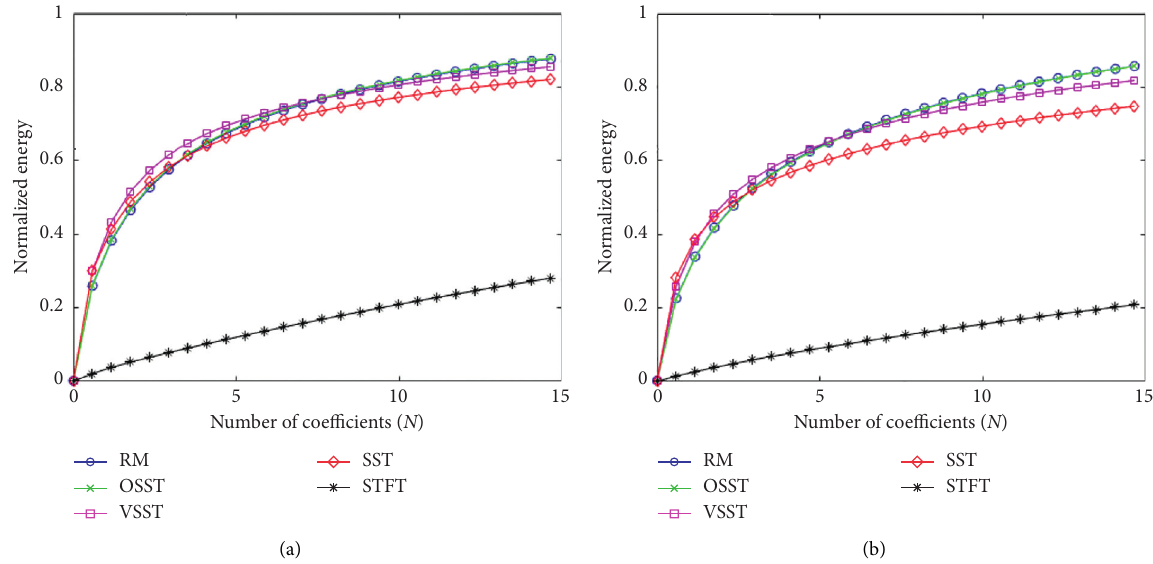
Figure 5: Cumulative normalized energy as a function of the number of coefficients for numerical simulation tests: (a) noise-free and (b) with noise (SNR � 0